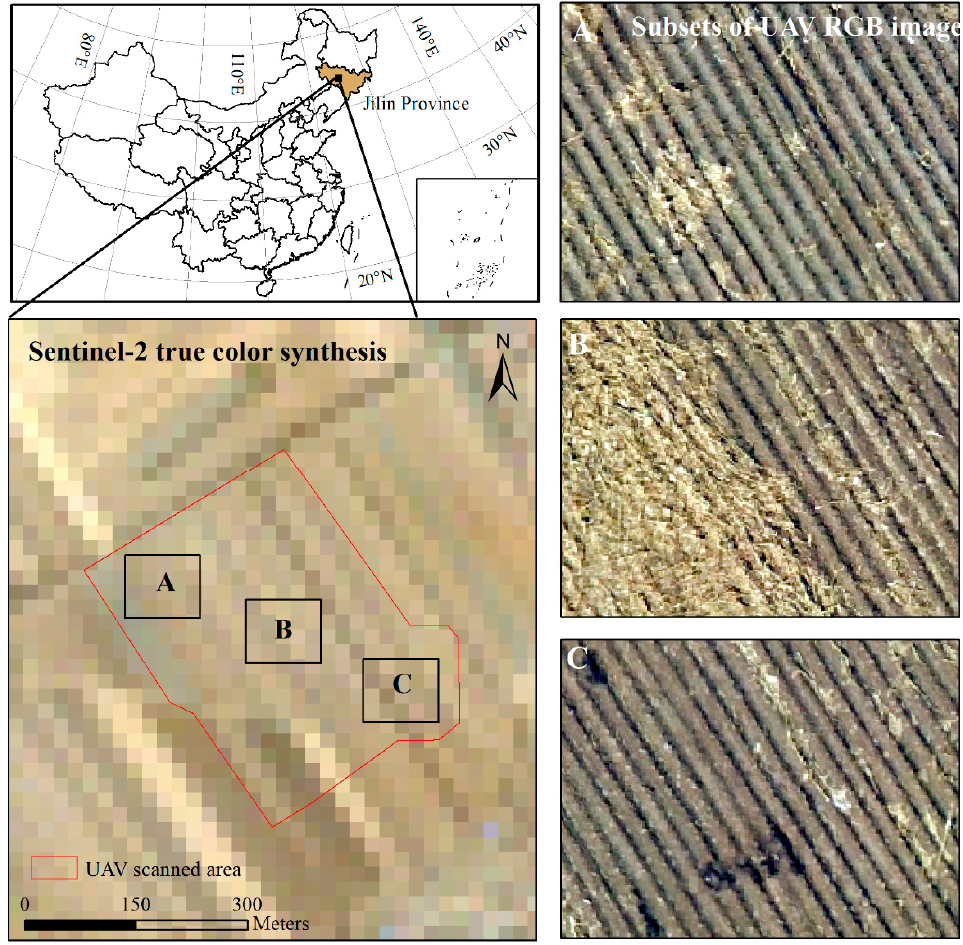
Figure 1. The location of the study area. Imagery on the left: Sentinel-2 true color synthesis of bands 2, 3, and 4. Imageries on the right: examples of unmanned aerial vehicle (UAV) images for sites ( A ), ( B ), and ( C ).